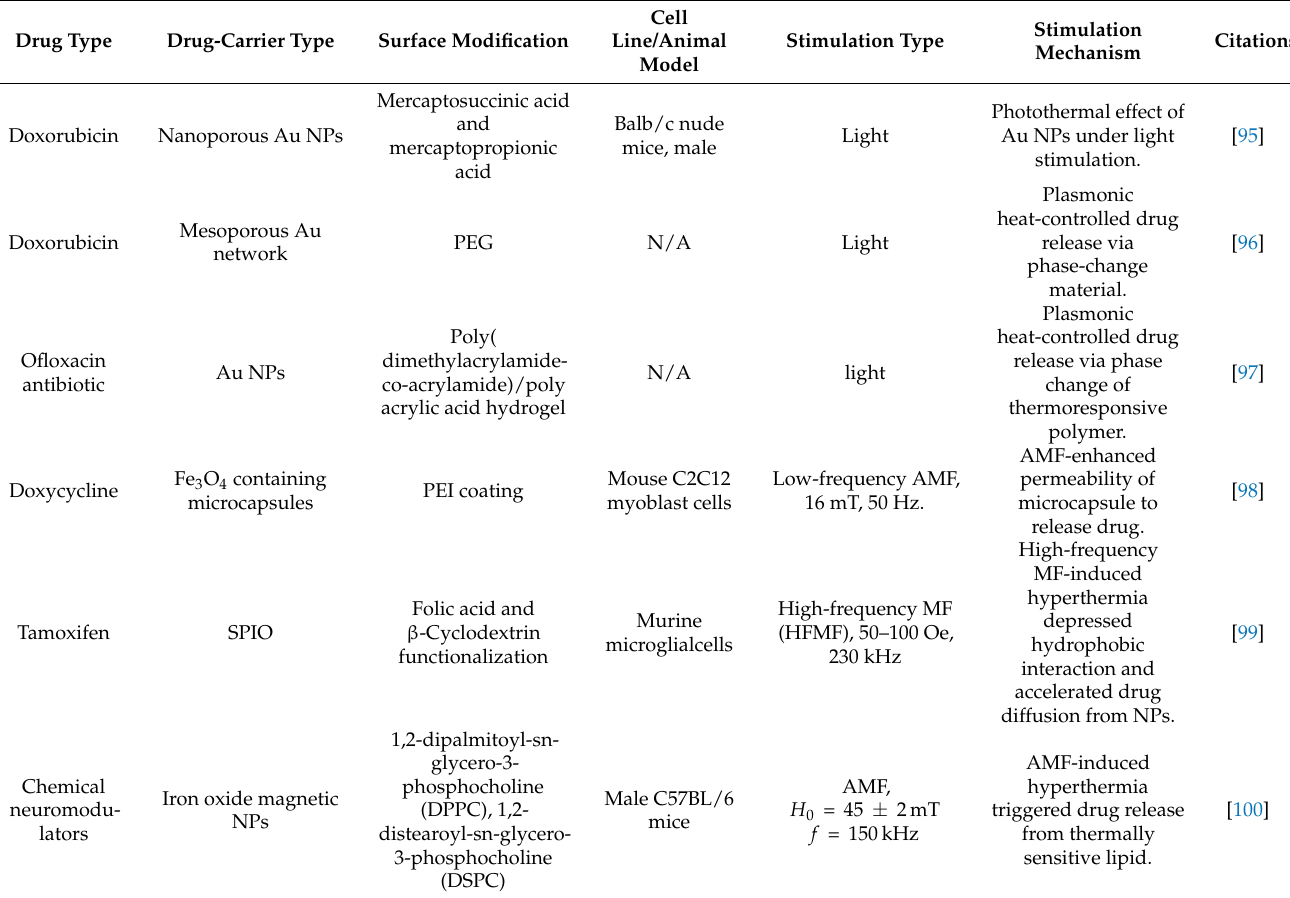
Table 3. Mechanisms of different stimulus-type-controlled drug release from magneto-plasmonic